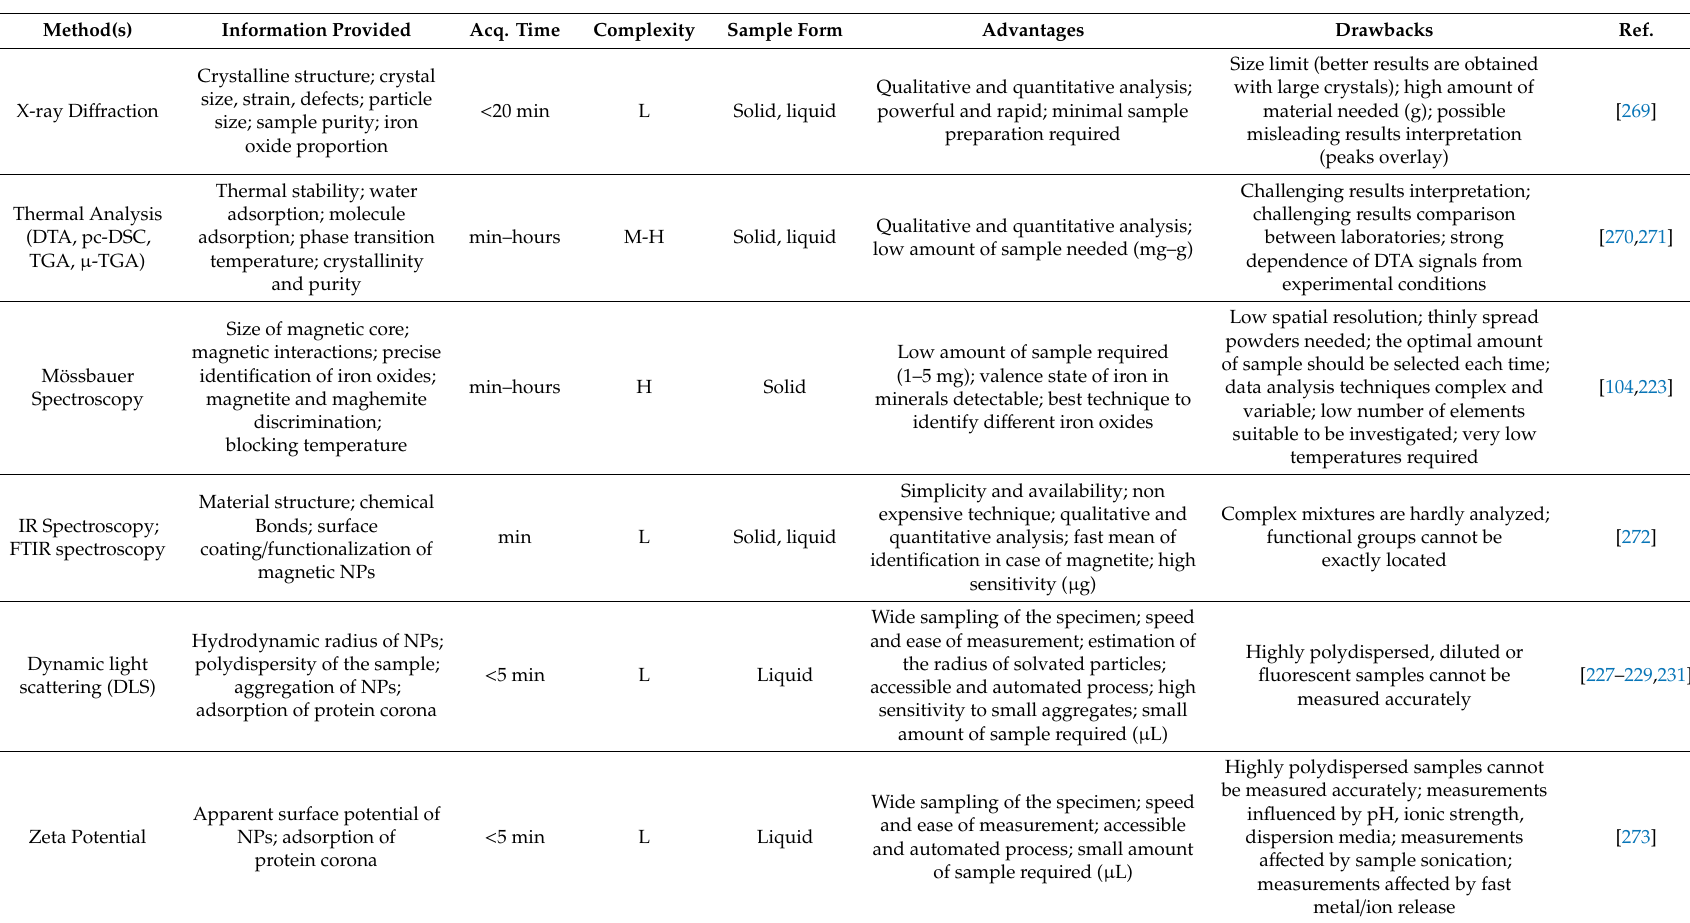
Table 2. Main properties of the techniques reported in the previous paragraph, useful to characterize magnetic systems designed for biomedical applications.